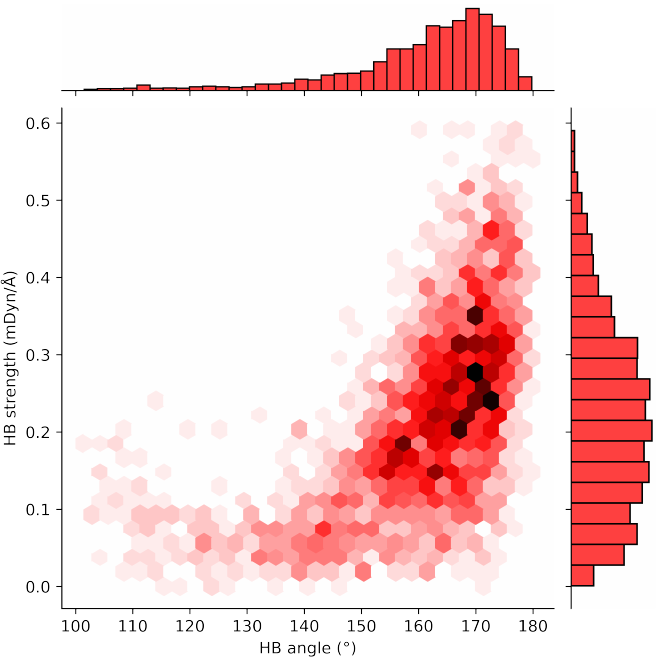
Figure 7. Relationship between hydrogen bond strength and angle in database B.